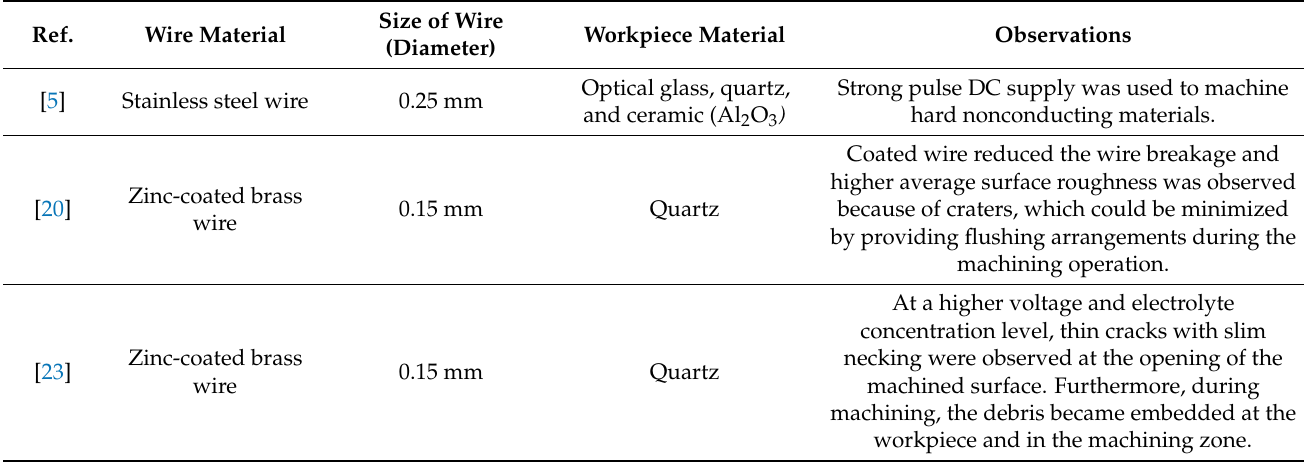
Table 1. Types of wire (tool electrode) used TW-ECDM processes [20].